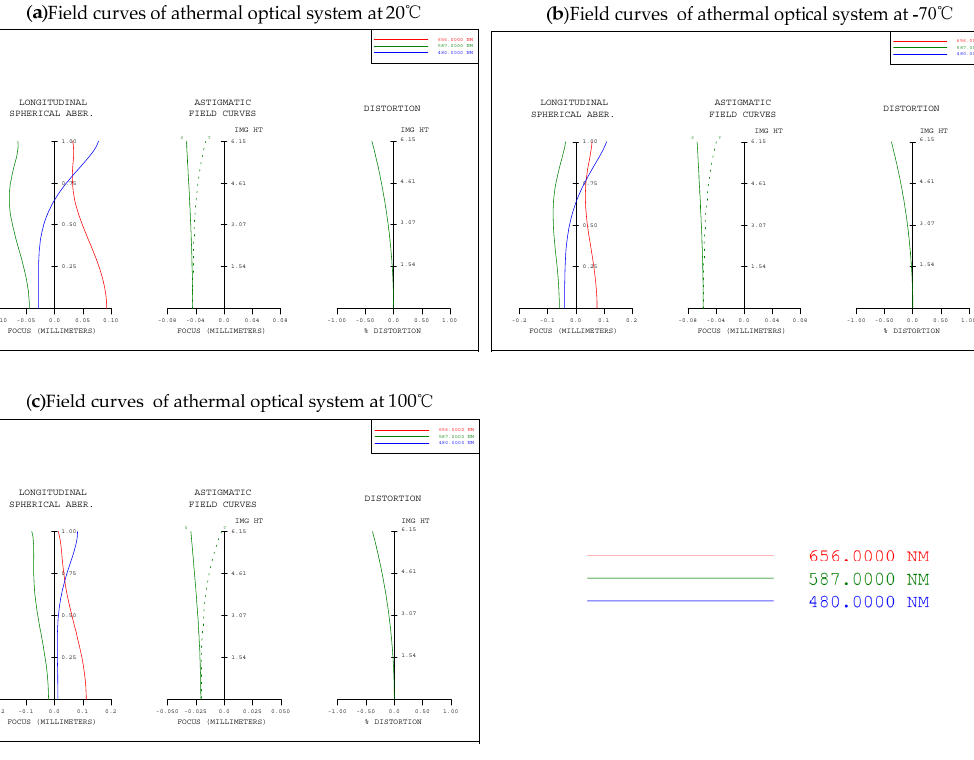
Figure 3. Field curves graphs of the passive athermal visible lens with temperatures: ( a ) 20 °C, ( b ) − 70 °C, and ( c ) 100 °C.